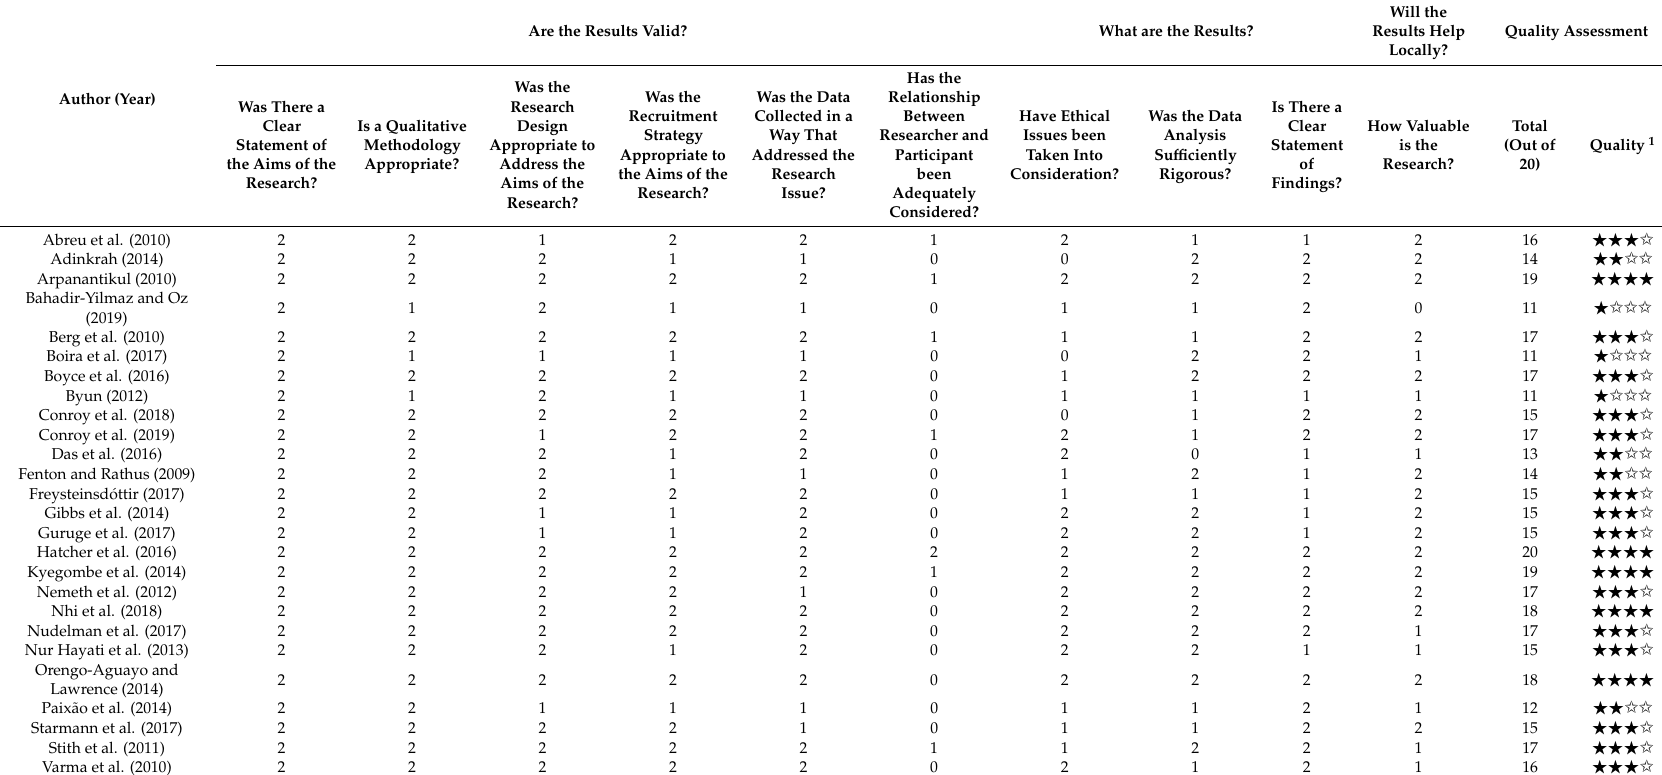
Table A4. Quality assessment of included qualitative